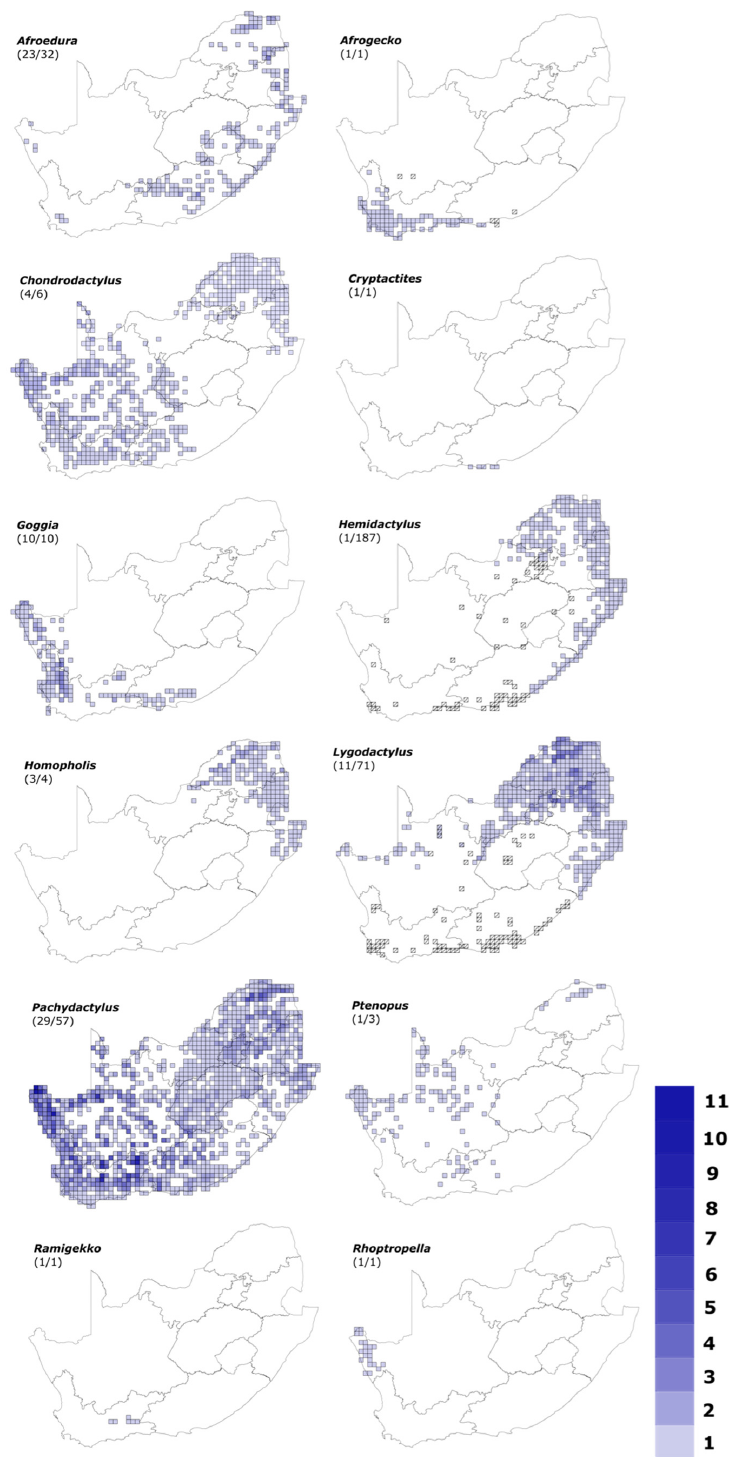
Figure 2. Species richness of gekkonid genera (shown separately) in South Africa, Lesotho, and Eswatini. Values in brackets indicate the number of species within the region relative to the number of species within the genus.